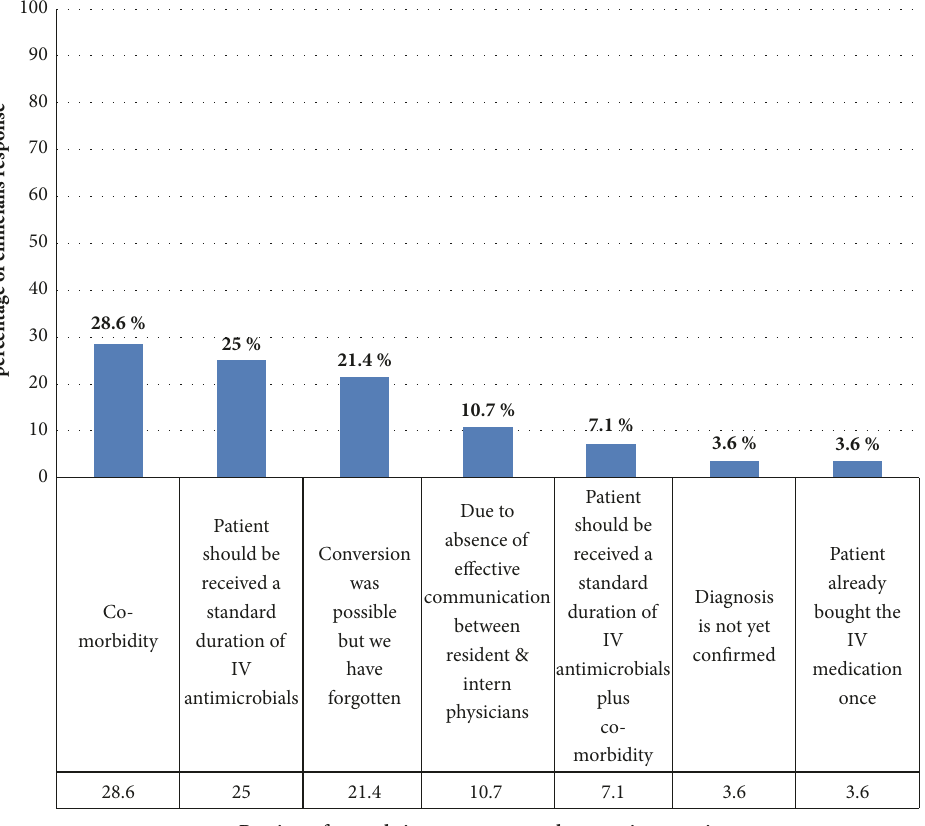
Figure 1: Physicians’ response about barriers of an early antimicrobialIV toPO conversionpracticeat JimmaUniversity Specialized Hospital, South West Ethiopia, February–September 2014 (n=28).